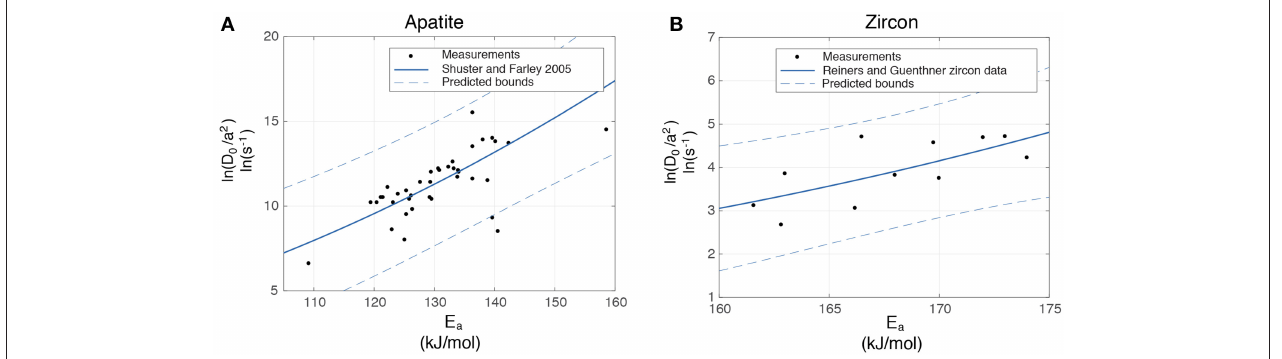
FIGURE 3 | Observed variability in activation energy and frequency factor for the diffusion of He in (A) apatite and (B) zircon crystals (Reiners et al., 2004; Shuster et al., 2006; Guenthner et al., 2013). In each panel, the black dots are the E a and D 0 / a 2 calculated from diffusion experiments on single crystals or sample aliquot. Solid blue line is power regression fit to this relation, parameter values given in text. Dotted lines are 95 % confidence bounds. Apatite data include diffusivity of both 4 He (natural) and 3 He (doped). Zircon data include the post-high-T results from Reiners et al. (2004) and samples RB140, BR231, M127 from Guenthner et al.